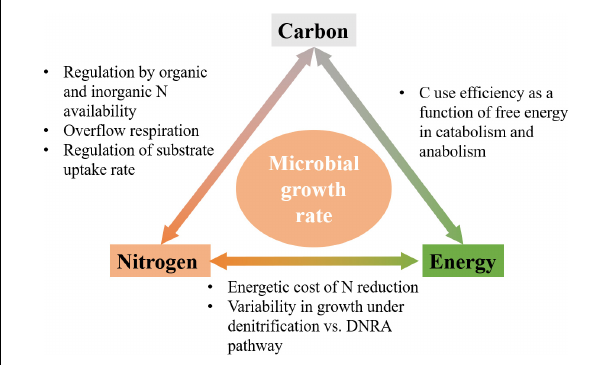
FIGURE 1 | Schematic of links among C, N, and energy flows, and mechanisms by which they affect microbial growth rate.